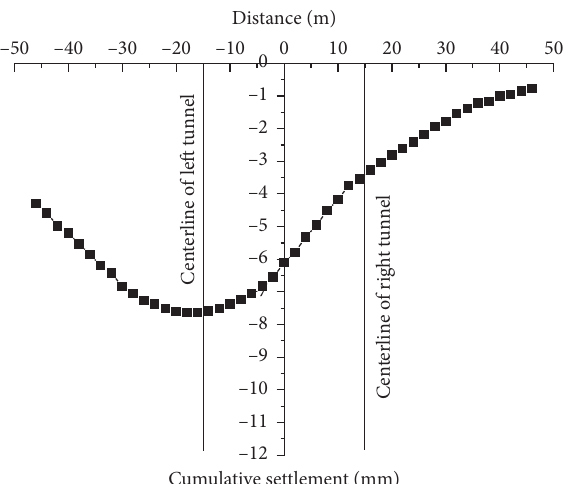
Figure 10: Cumulative settlement of left-line tunnel underpass.